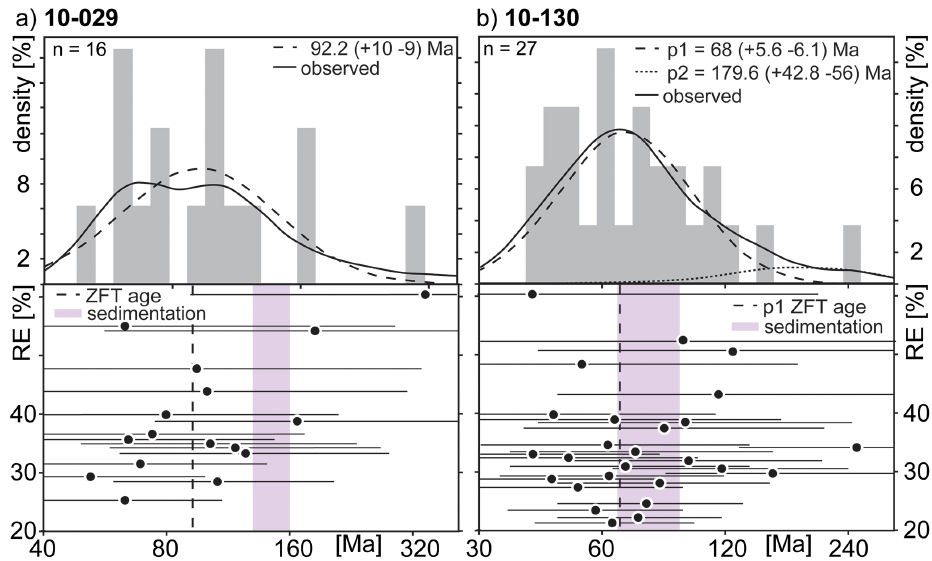
Figure 8. Age density histograms for “detrital” FT ages with distribution curves ( n is number of grain measured, p is population, RE is relative error in %) calculated with Binomfit (Brandon, 1996). (a) Zircon age distribution of grain-supported conglomerate 10-029 belonging to the uppermost Jurassic–Lower Cretaceous “flysch” of the AVAZ (IGME, 1991). (b) Zircon age distribution from non-metamorphic, Upper Cretaceous conglomerate